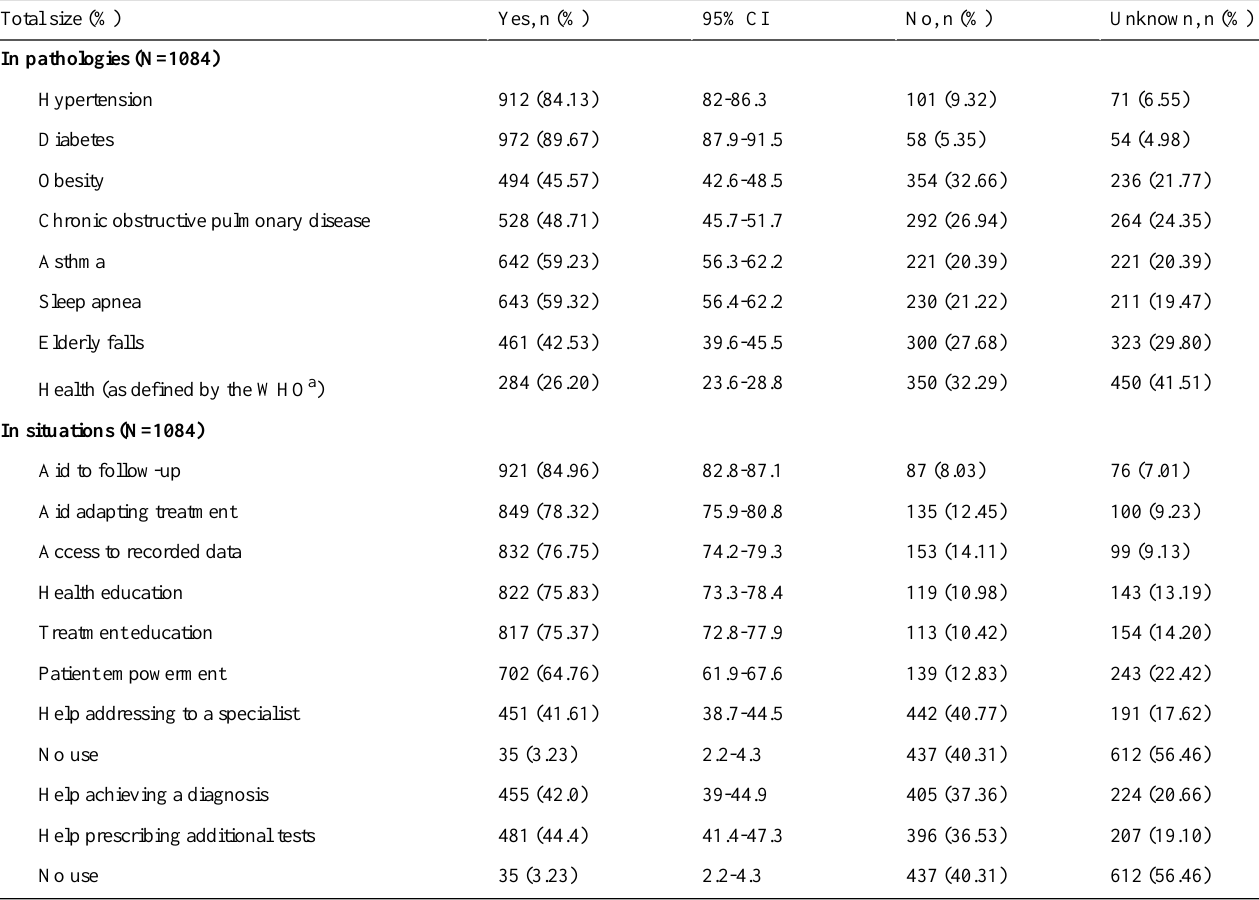
Table 2. Pathologies in which connected health devices (CHDs) could be useful according to general practitioners (GPs; N=1084).